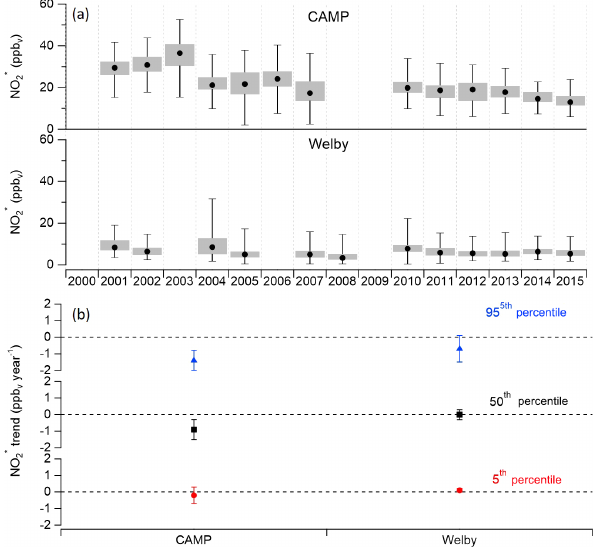
Figure 3. (a) Trends in summer (1 June–31 August) daytime (10:00–16:00LT) NO ∗ for the CAMP and Welby sites in Denver 2 for all available data from 2000 to 2015. Whiskers correspond to 5th and 95th percentiles, box thresholds correspond to 33rd and 67th percentiles, and the black marker corresponds to the 50th per- Figure 4. (a) Estimated yearly averaged natural gas withdrawals centile. (b) NO ∗ temporal trends were determined as the slope from 2 in Colorado (US-EIA, 2017). (b) Yearly average number of ac- annual trends (ppbv NO 2 yr − 1 ) from simple one-sided linear re- tive ONG well operations (US-EIA, 2017). (c) Anthropogenic VOC gression for the six NFRMA sites for the 95th (blue triangles), 50th emission estimates from the EPA state average annual emissions (black squares), and 5th (red circles) percentiles. Error bars repre- trend for Colorado (EPA, 2016b). Emission sources are separated sent the 95% confidence interval around the NO ∗ yr − 1 linear re- 2 by color and are added to give the total VOC emission estimates gression slope. for anthropogenic VOCs. Biogenic VOCs and VOCs from biomass burning (controlled fires and wildfires) are not